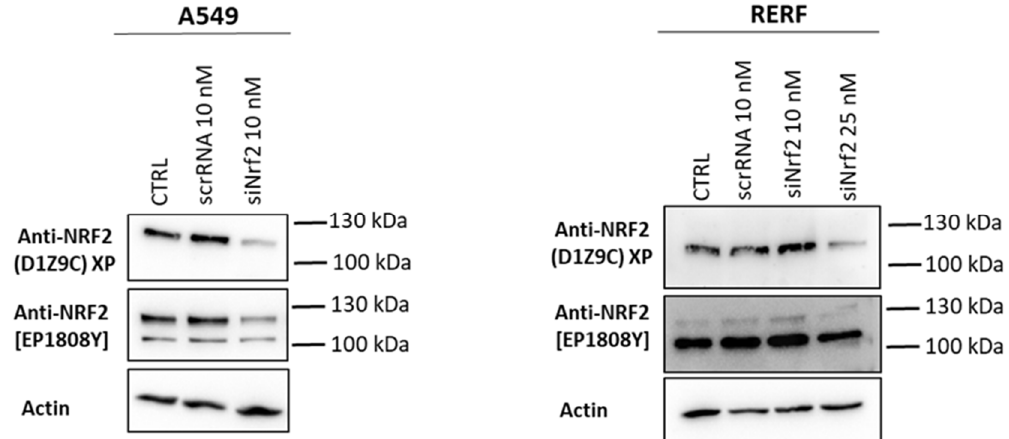
Figure 2. Nrf2 knockdown in A549 and RERF cells detected by two different monoclonal antibodies. Nrf2 expression was silenced with Nrf2-targeting siRNAs for 48 h: 10 nM (A549) and 10 nM and 25 nM (RERF). Nrf2 signal was detected with two monoclonal antibodies: Cell Signaling (D1Z9C) and Abcam [EP1808Y]. Actin was used as a loading control. scrRNA is a control unspecific siRNA.